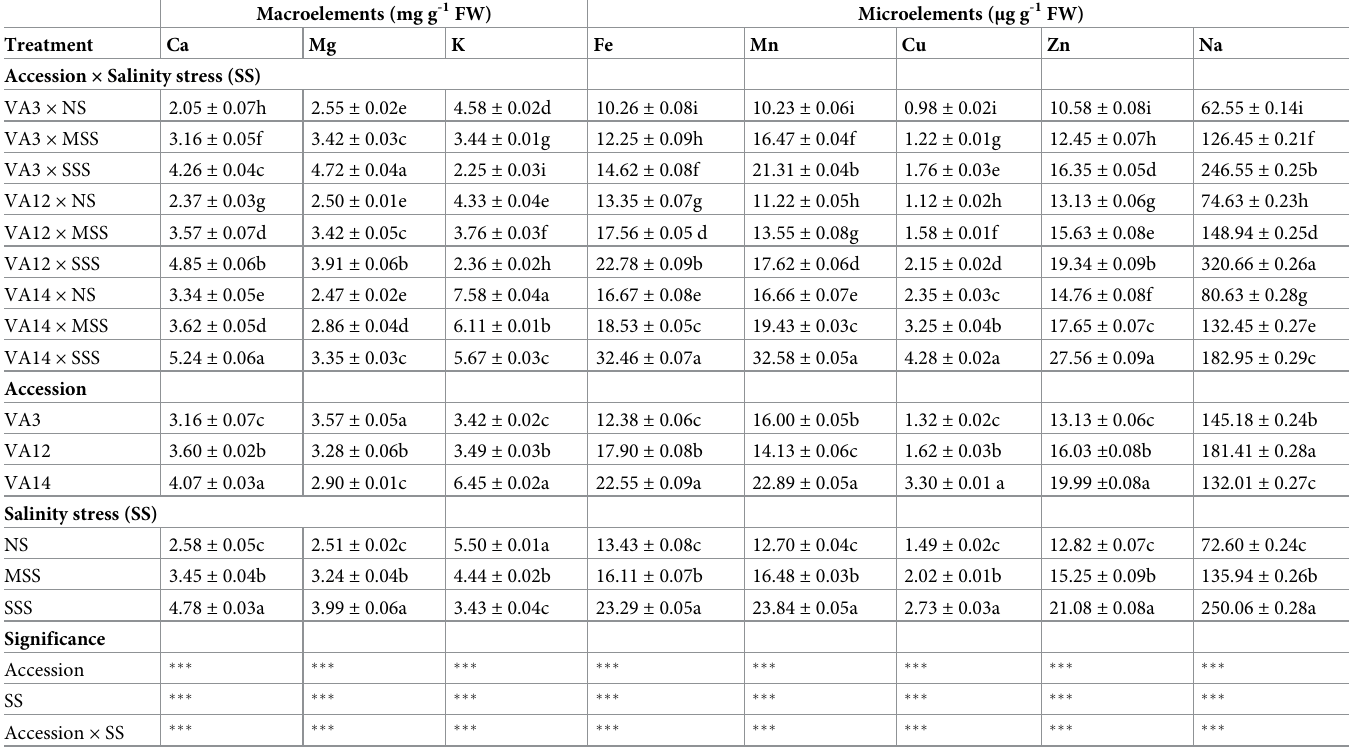
Table 2. Salinity stress on mineral composition (macro mg g -1 FW and micro μ g g -1 FW nutrient elements) in the leaves of three selected A . tricolor accessions.